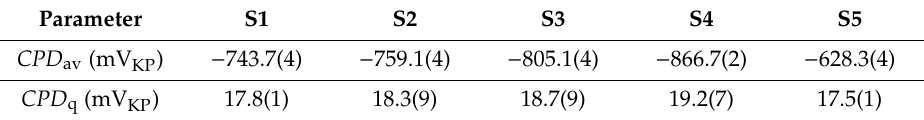
Figure 12. The CPD maps determined for the AISI 1010 carbon steel after the experiment in sulfolane at 95 ◦ C and etching ( a ); the experiment in sulfolane with the addition of 1 vol.% of water at 95 ◦ C and etching ( b ); the experiment in sulfolane with the addition of 2 vol.% of water at 95 ◦ C and etching ( c ); the experiment in sulfolane with the addition of 3 vol.% of water at 95 ◦ C and etching ( d ); after the experiment in sulfolane at 95 ◦ C without etching ( e ). Table 4. Statistical parameters obtained for the contact potential di ff erence ( CPD ) maps of the AISI 1010 carbon steel after the experiment in sulfolane at 95 ◦ C and etching (S1); the experiment in sulfolane with the addition of 1 vol.% of water at 95 ◦ C and etching (S2); the experiment in sulfolane with the addition of 2 vol.% of water at 95 ◦ C and etching (S3); the experiment in sulfolane with the addition of 3 vol.% of water at 95 ◦ C and etching (S4); and after the experiment in sulfolane at 95 ◦ C without etching (S5); indexes: av and q refer to average and root mean square value; V KP is the voltage measured in relation to the Kelvin